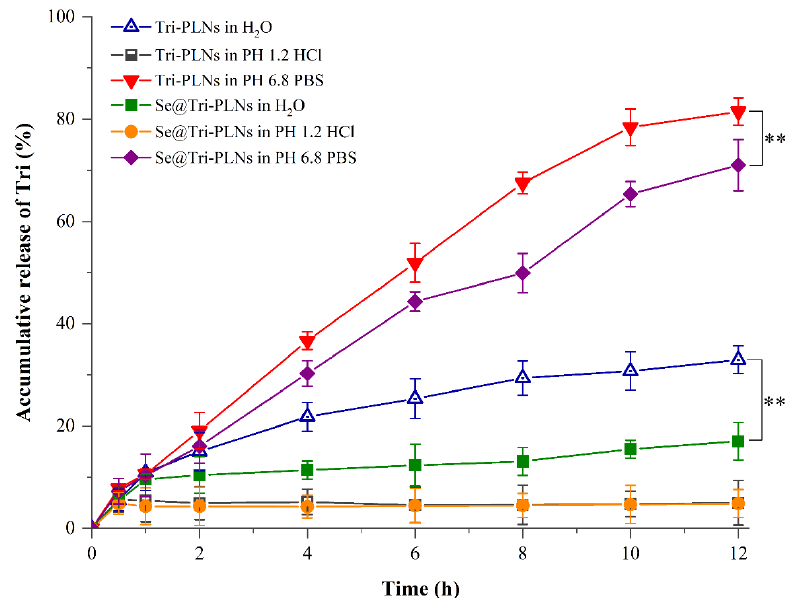
Figure 5. Release profiles of Tri from Tri-PLNs and Se@Tri-PLNs in deionized water, pH 1.2 HCl solution, and pH 6.8 phosphate buffer solution (PBS). Data expressed as mean ± SD ( n = 3), paired t -test, ** p < 0.01.